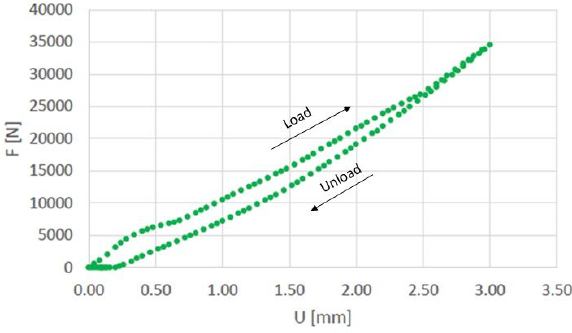
Figure 10: Compression characteristics of gasket variant No. 110